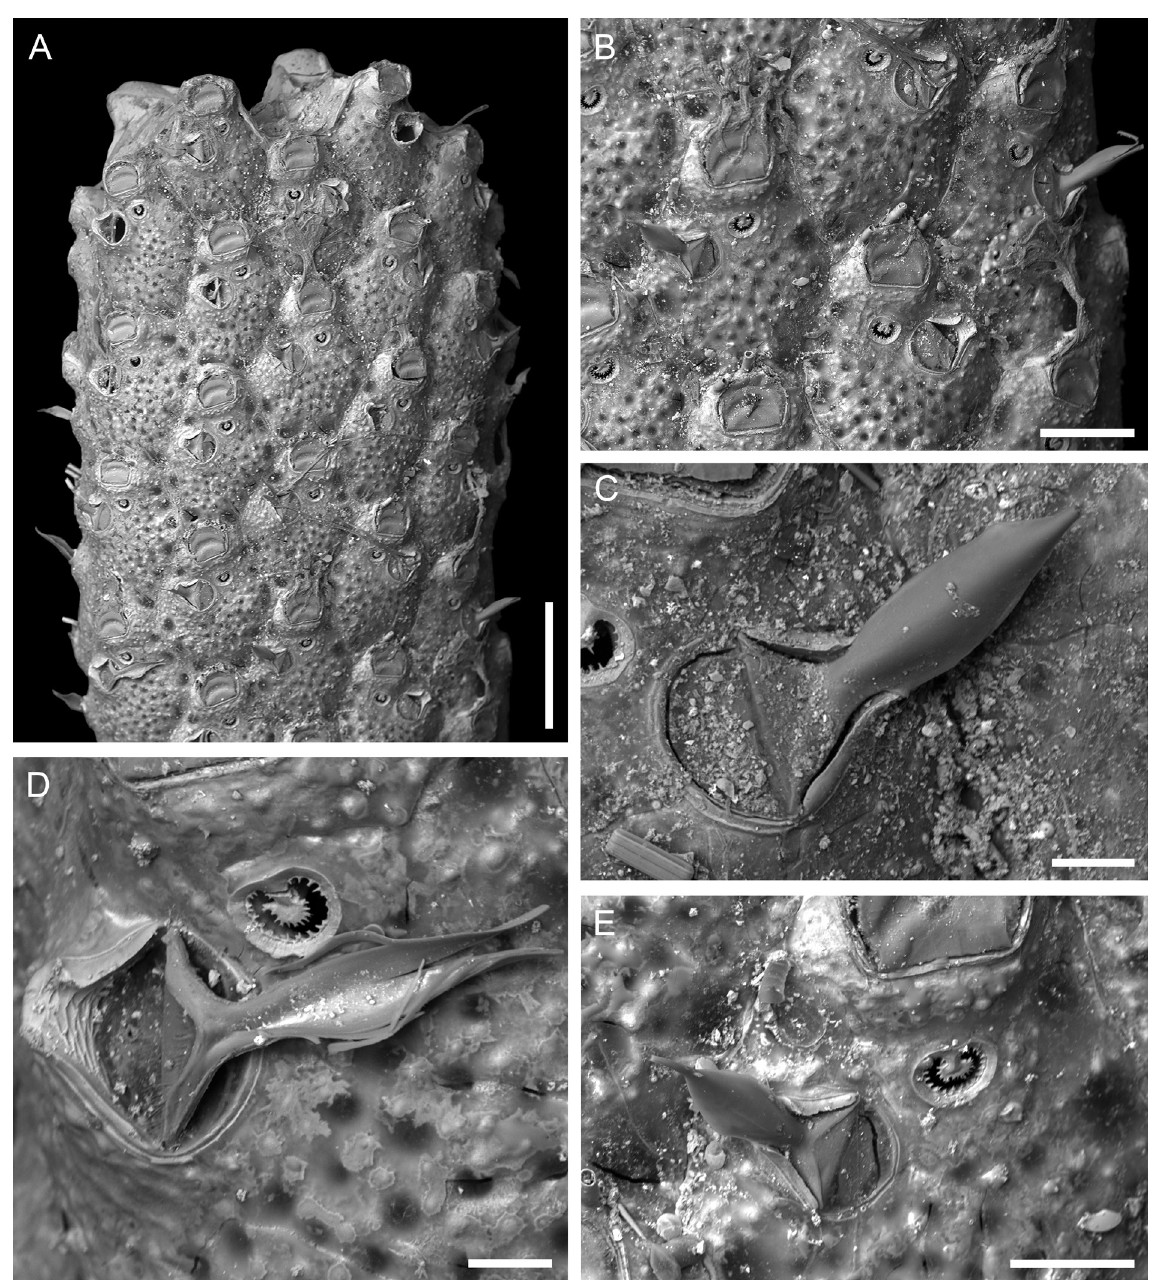
Fig. 4. Microporella hastigera (Busk, 1884), lectotype, NHMUK 1887.12.9.547 (unbleached), Recent, Challenger Expedition, St. 75. A . Group of zooids at the branch tip. B . Close-up of autozooids. C–E . Close-ups of the ascopore and adventitious avicularium with the lanceolate mandible either closed (C, E) or open (D). Scale bars: A = 500 µm; B = 200 µm; C–D = 50 µm; E = 100